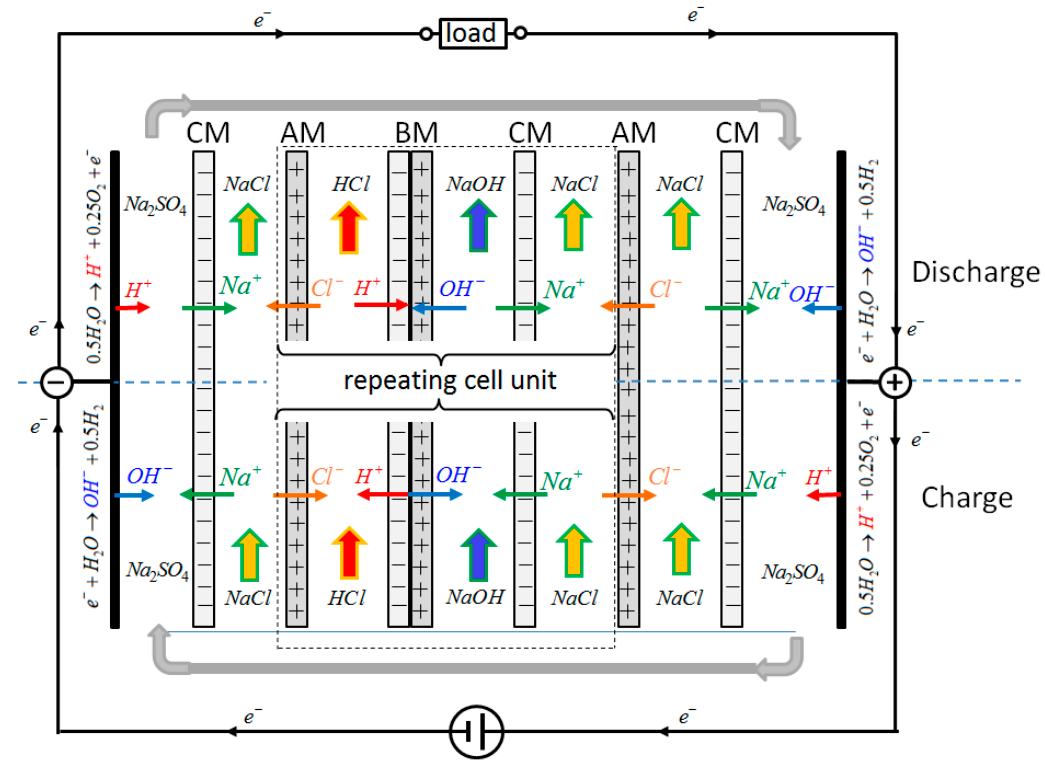
Figure 1. Schematic of main ionic fluxes and electrode reactions of the REDBP (reverse electrodialysis with bipolar membranes) stack used, in the lower part during charge and in the upper part during discharge. Only one of several repeating cell units is shown between the electrode compartments. The respective electrode reactions during charge and discharge are indicated at the electrodes. CM: cation exchange membrane, AM: anion exchange membrane, BM: bipolar membrane.